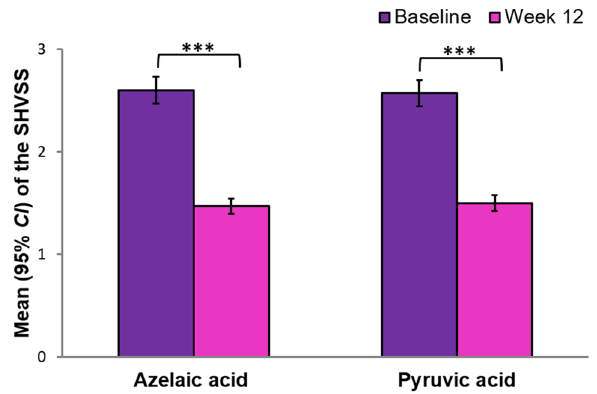
Figure 1. Mean scores of the Scale of Hellegren–Vincent Severity Symptoms (SHVSS) at baseline and 12 weeks after treatment with azelaic or pyruvic acid. The error bars are the 95% confidence interval ( CI ). *** p < .001.